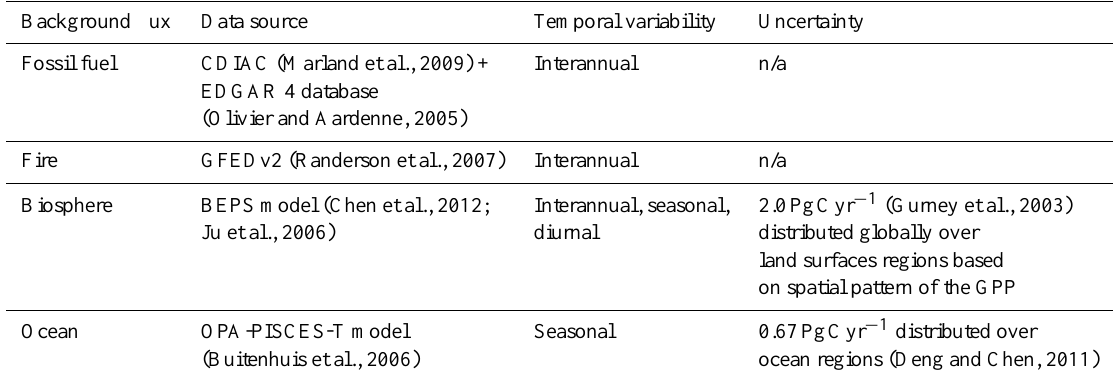
Table 1. Summary of background prior fluxes and their